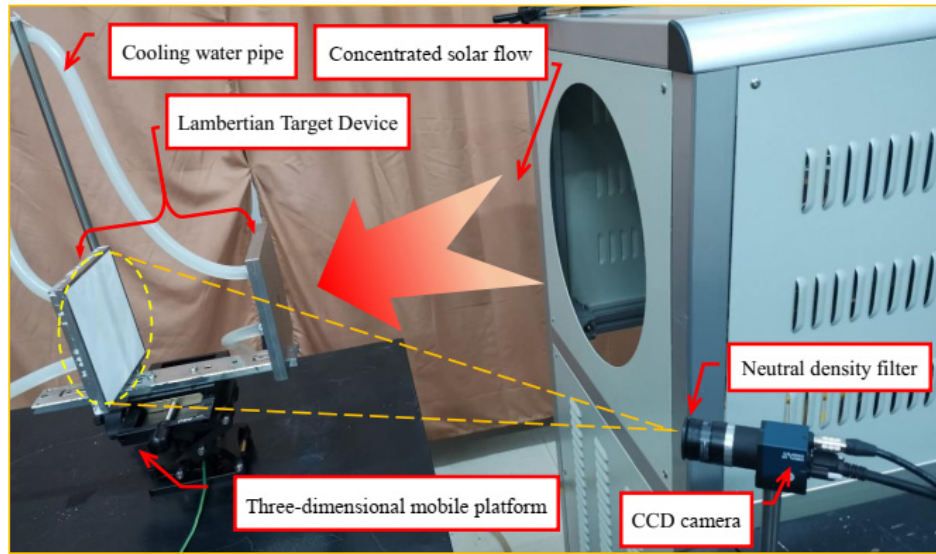
Figure 2. Experiment apparatus of the CSRF measurement.